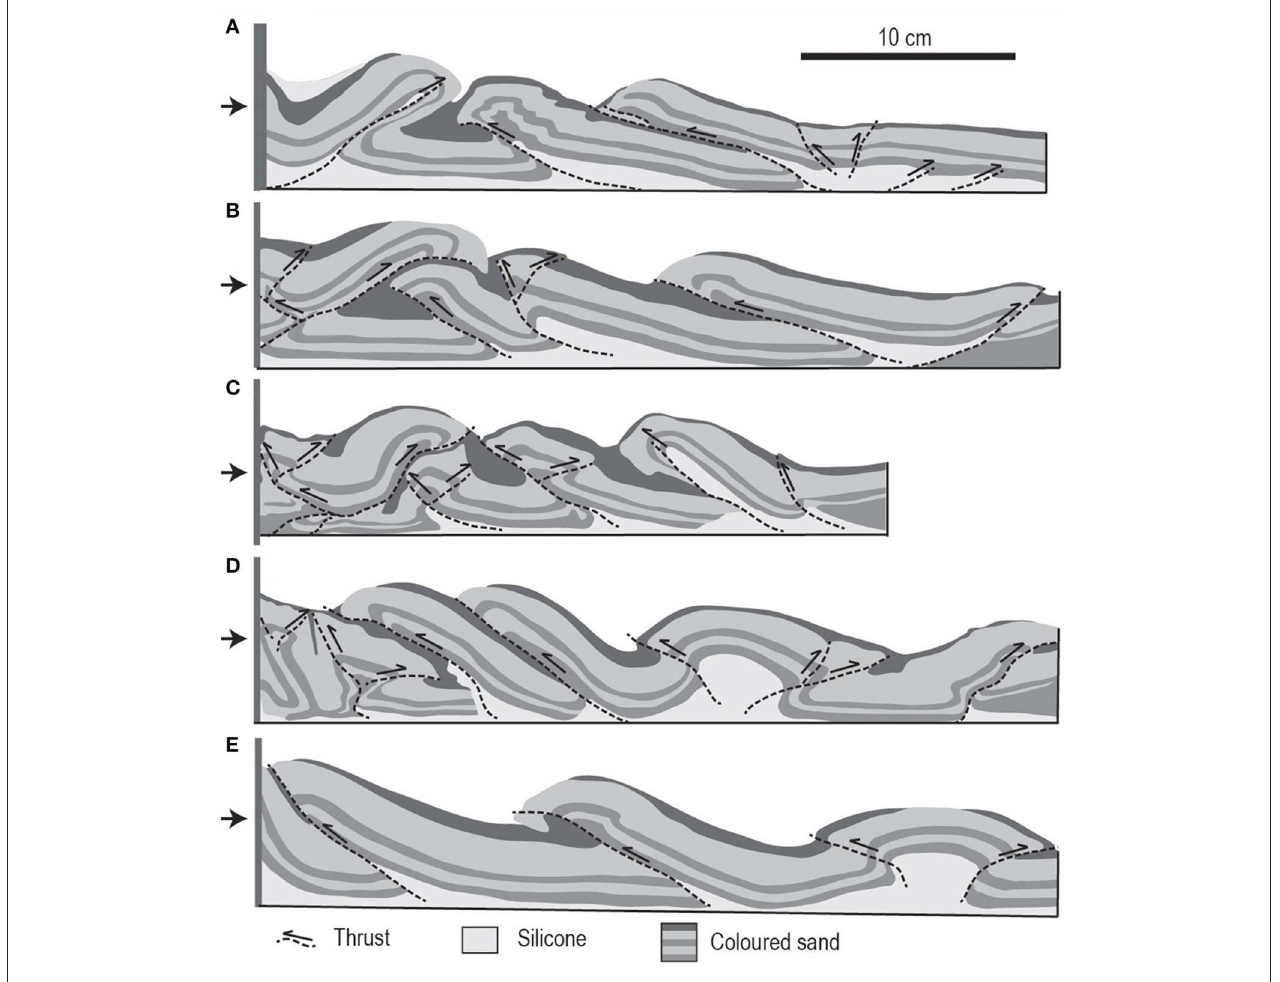
FIGURE 9 | Series of cross sections (A–E) of Model 4-1 (location on Figure 6 ).